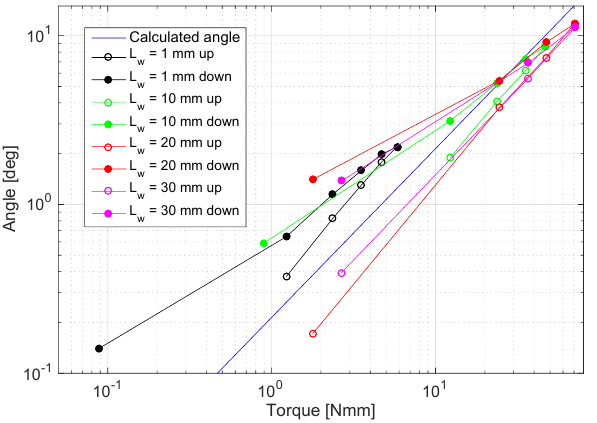
Figure 5. Rotation angle versus torque (Delamare et al., 2016).